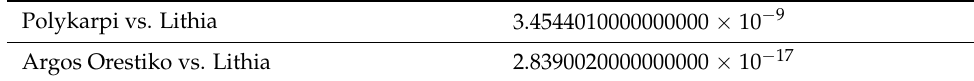
Table A5. p -values of Hotteling’s